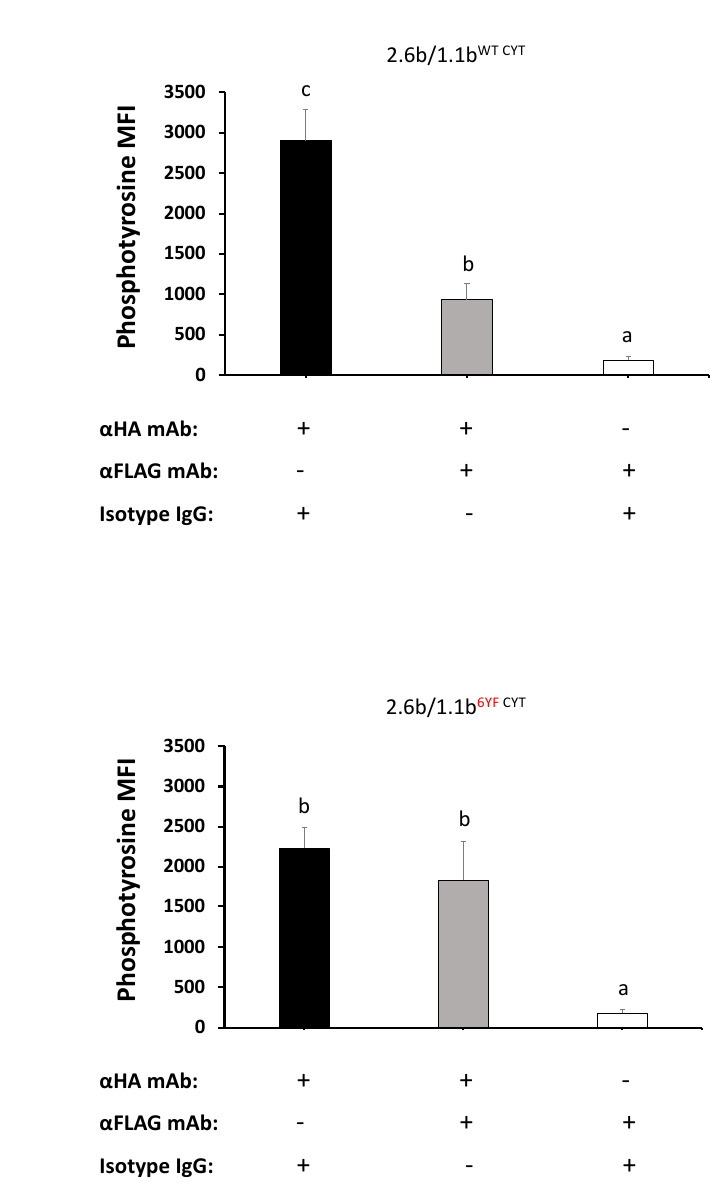
Figure 3. Down-regulation of 2.6b ITAM CYT -mediated phosphotyrosine signaling following co-crosslinking with 1.1b WT CYT . AD293 cells (2 × 10 5 ) co-expressing 2.6b ITAM CYT / 1.1b WT CYT ( A ) and 2.6b ITAM CYT / 1.1b 6YF CYT ( B ) were incubated with 3.55 µ m light-yellow (LY) beads (6 × 10 5 ). LY beads were opsonized with α -HA and α -FLAG mAbs to co-crosslink 2.6b ITAM CYT and 1.1b CYT constructs, respectively. To independently crosslink 2.6b ITAM CYT or 1.1b CYT constructs, LY beads were opsonized with α -HA or α -FLAG mAbs alone, respectively. After 15 min at 37 ◦ C, cells were permeabilized and intracellularly stained with an Alexa 488-conjugated α -phosphotyrosine mAb and cells were then analyzed using an ImageStream X Mark II instrument. Fluorescent intensity of cells associated with LY beads was calculated and represented as mean fluorescent intensity (MFI). Each bar represents the mean ± SEM of four independent experiments. Di ff ering letters indicate statistical significance ( p ≤ 0.05) between means. Experimental groups were compared using a one-way ANOVA, followed by the Tukey test using Prism 6 software (GraphPad Software, La Jolla, CA, USA).